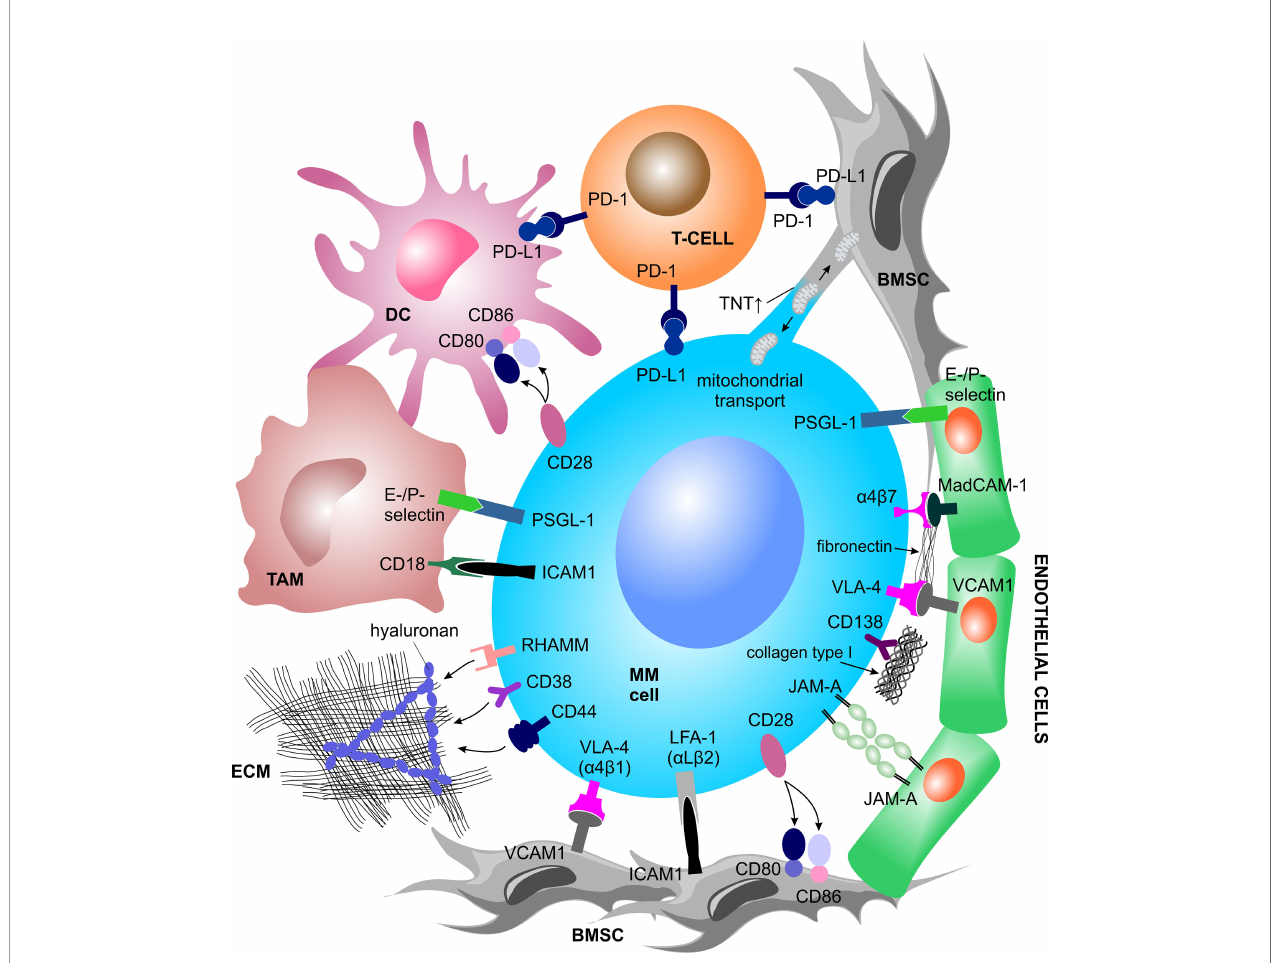
FIGURE 1 | Contact dependent interactions between MM cells and the TME. MM cells physically interact with various other BM-homing cell types and the ECM structures via receptor-ligand binding or tunneling nanotubes. Such interactions trigger a plethora of inter- and intracellular signal cascades which support MM cell growth and metabolism, immune evasion and therapy resistance. BMSC, bone marrow stromal cell; DC, dendritic cell; ECM, extracellular matrix; ICAM-1, intercellular adhesion molecule 1; JAM-A, junctional adhesion molecule A; LFA-1, lymphocyte function-associated 1; MAdCAM-1, mucosal vascular addressin cell adhesion molecule 1; MM, multiple myeloma; PD-1, programmed cell death protein 1; PD-L1, programmed cell death 1 ligand 1; PSGL-1, P-selectin glycoprotein ligand-1; RHAMM, receptor for hyaluronan mediated motility; TAM, tumor associated macrophage; TNT, tunneling nanotubes; VCAM1, vascular cell adhesion molecule 1; VLA-4, very late